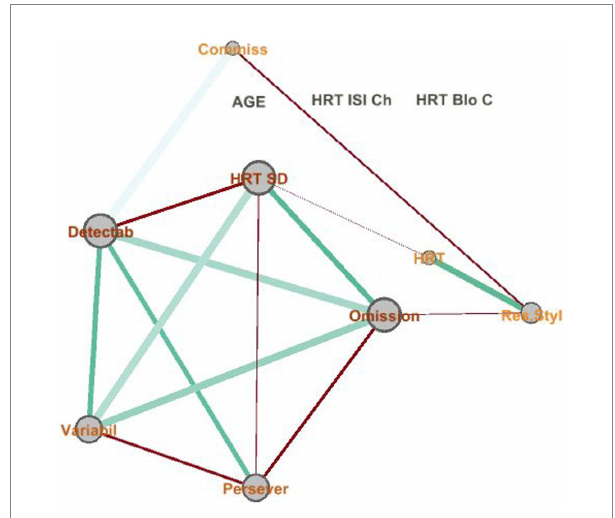
FIGURE 3 Network relationship between numerical features. The graph represents each continuous variable as a node, indicating the size of the node as a function of degree (the number of edges). Both the size and color depend on Spearman’s rho